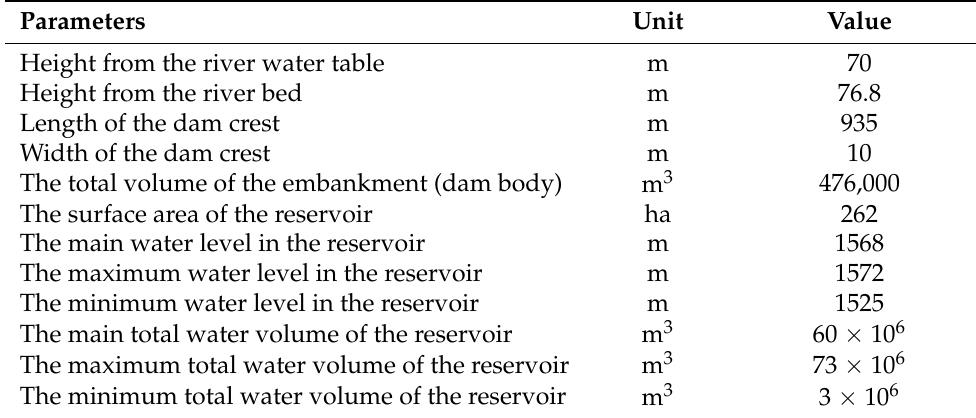
Table 1. Geometrical characteristics for the Alavian dam and